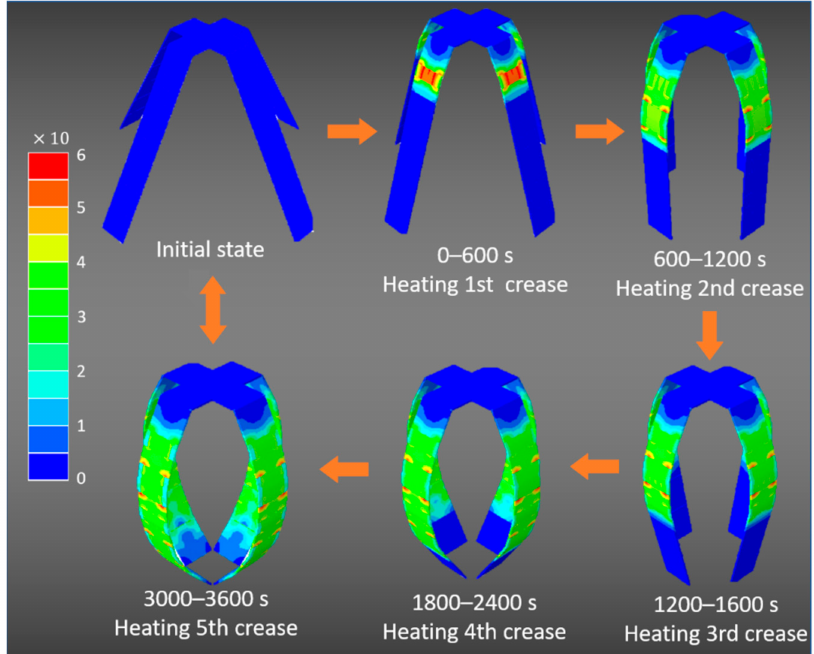
Figure 7. Self-folding configurations with time for the origami microgrippers triggered by tempera- ture